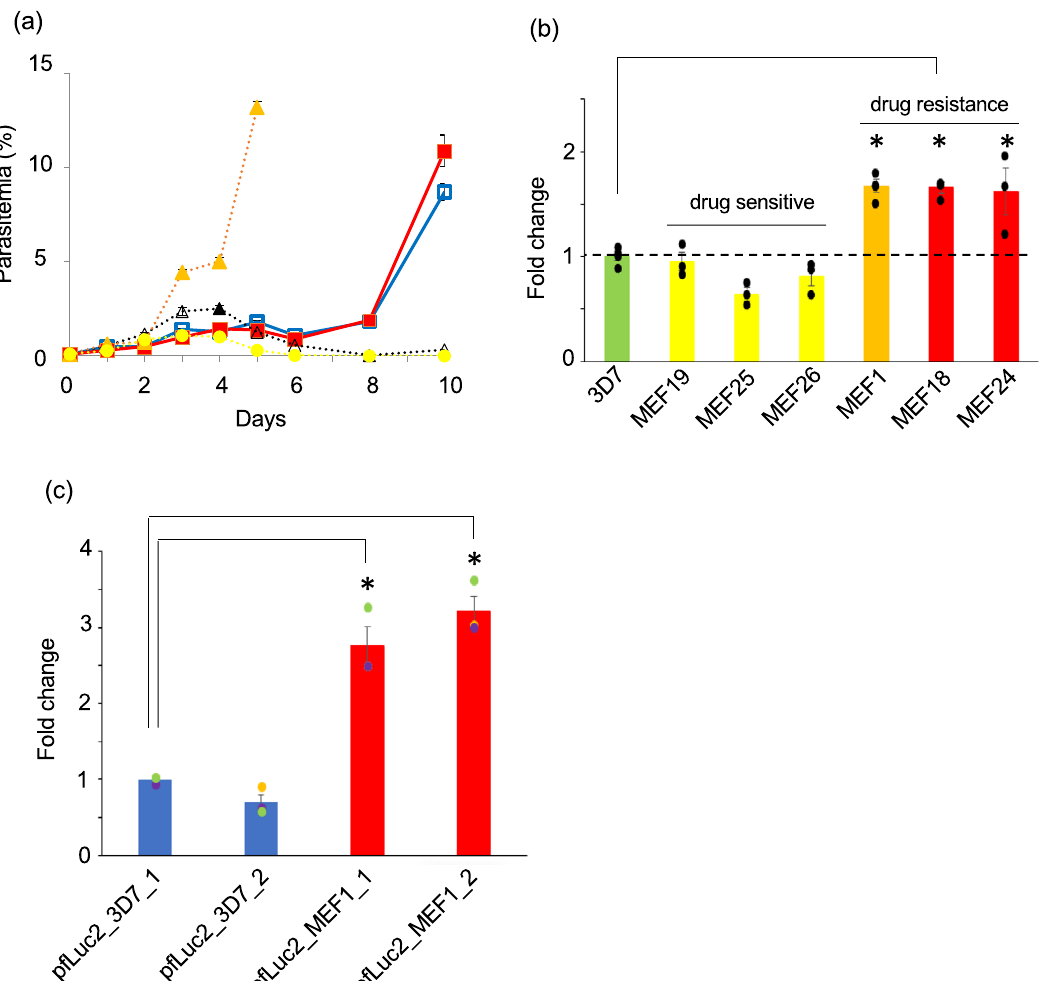
Fig.4 |Me fl oquineresistancecausedbyPfMDR7.a Theme fl oquineresistanceof a transgenic parasite, into which pfmdr7 of the MEF1(red) and the 3D7 (blue) were introduced, were examined. In addition, the me fl oquine resistance of the 3D7 (black), the MEF1 (orange), and the negative control parasite (yellow) into which only pFCENv1 was introduced were also examined. b The mRNA level of pfmdr7 in theMEF1(orange)wasanalyzedbyRT-qPCR.Inaddition,thoseofthreeme fl oquine- sensitive (yellow) and two me fl oquine-resistant parasites (red), which were col- lected from patients living in the Thai – Myanmar border area, were